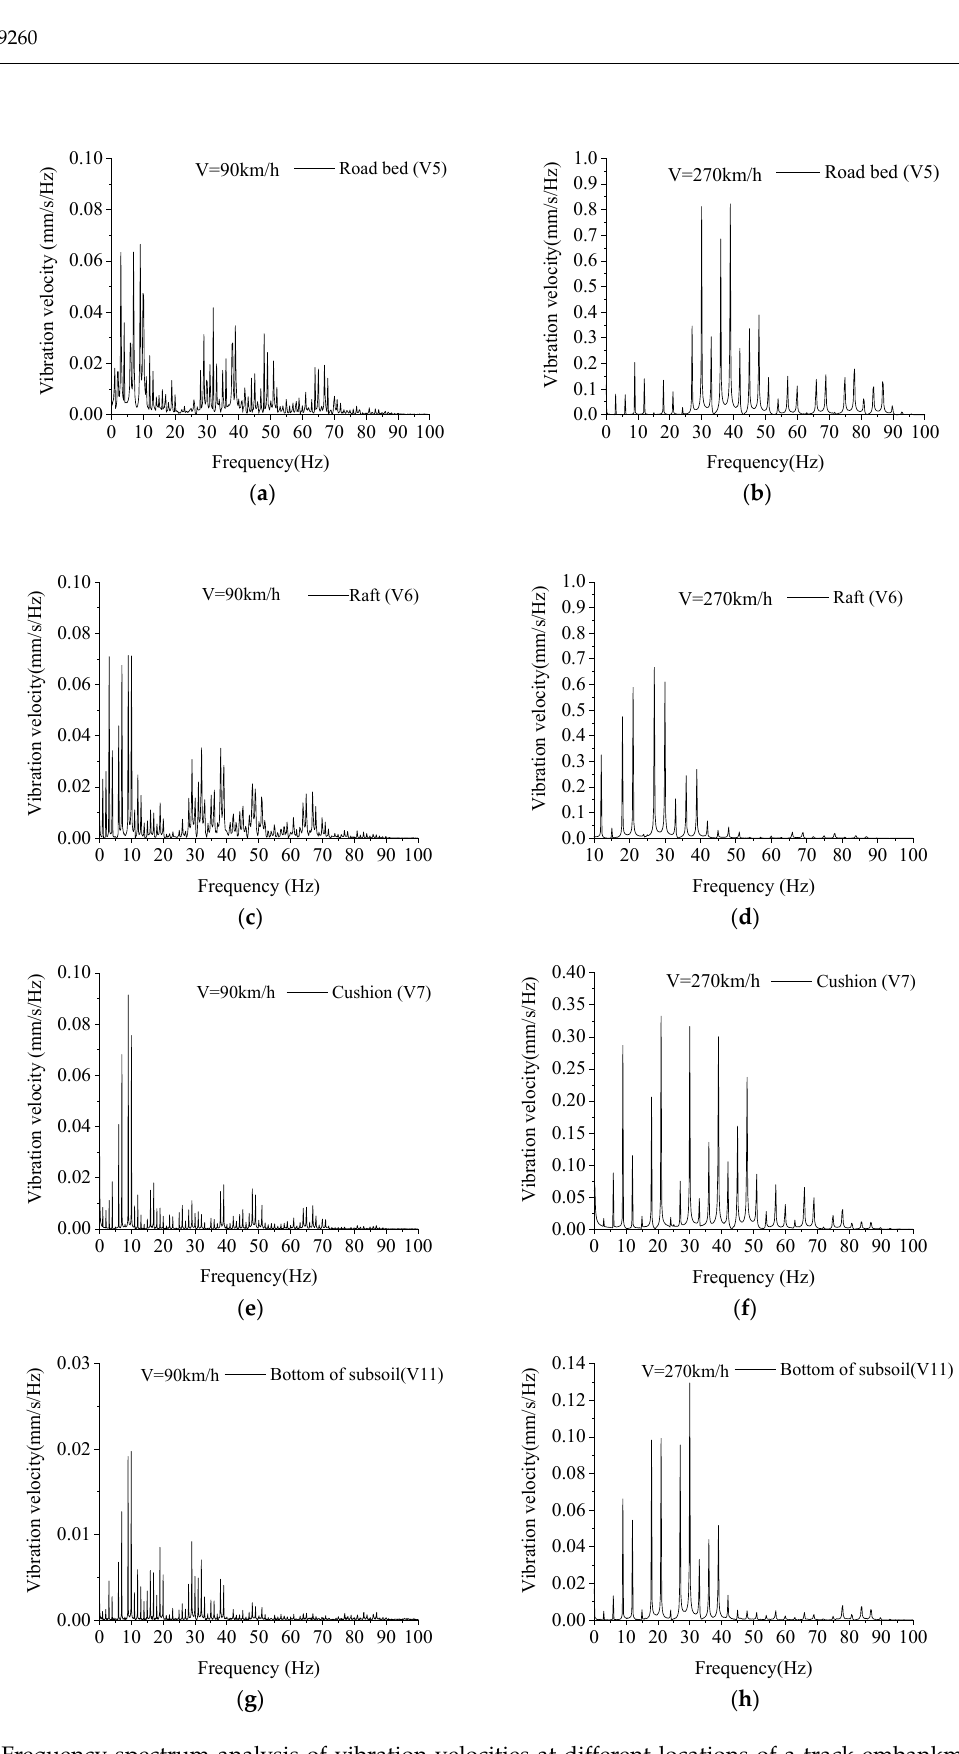
14 of 27 Figure 9. Time history curves of vibration velocities at different locations of the pile–raft foundation. ( a ) Roadbed (V5, v = 90 km/h), ( b ) Roadbed (V5, v = 270 km/h), ( c ) Raft (V6, v = 90 km/h), ( d ) Raft (V6, v = 270 km/h), ( e ) Cushion (V7, v = 90 km/h), ( f ) (f) Cushion (V7, v = 270km/h), ( g ) Bottom of subsoil (V11, v = 90 km/h), ( h ) Bottom of subsoil (V11, v = 270 km/h). The frequency contents of the vibration velocities at the road, raft, and subsoil are shown in Figure 10. For v = 90 km/h, the peak values appear at a frequency point below 10 Hz, including 1, 3, and 9 Hz, reflecting the characteristic frequencies of the geometry of the train compartment. The peak values of the vibration velocity frequency spectrum are distributed in low-frequency and medium-frequency regions, respectively. In Figure 10a, there is a small amplitude of vibration energy in the 27~40 Hz region of the roadbed, and the vibration wave is enhanced in this frequency band, indicating that the character- istic frequency of the vibration of the roadbed packing is distributed in this region. In Figure 10b, for v = 270 km/h, information of the frequency contents shows peaks at about 3, 9, and 27 Hz. Compared with the low speed, the peak points of the vibration speed spectrum gradually move to the medium-frequency area, and increase with the increase of the train speed. Larger velocity spectrum peaks occur in the range of 27~40 Hz, which is 8 times more than that at low speed, and the ratio of vibration energy is higher than that at low speed. For low speed and high speed, the frequency contents of the vibration velocity are mainly distributed in the low and medium region, the peak values of which respectively correspond to the passing frequency of the train carriage geometry ( l c = 25 m), bogie ( l ab = 7.5 m), and axle distance ( l wb = 2.5 m), reflecting the characteristic frequencies of the train compartment, adjacent bogie, and wheel load passing through. The peak spectrum at high speed is significantly higher than that at low speed. A similar pattern can be found in Figure 10c–h, where the difference is the attenua- tion amplitude of the velocity spectrum at different locations. From the roadbed and the raft to the bottom of the subsoil, the distribution area and peak frequencies of the ampli- tude spectrum of the vibration velocity changes with the depth. The peak values of the frequency spectrum gradually decrease and move from the medium- to low-frequency energy distribution area along the vertical depth, and the medium-frequency parts of the